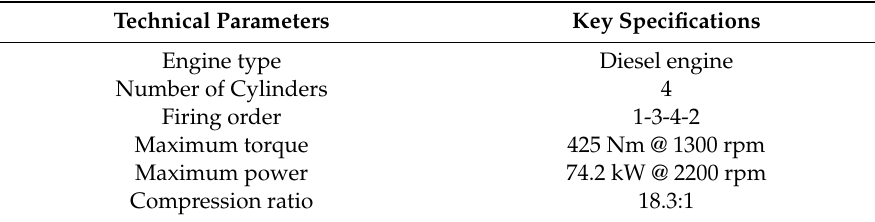
Table 1. Diesel engine specifications.